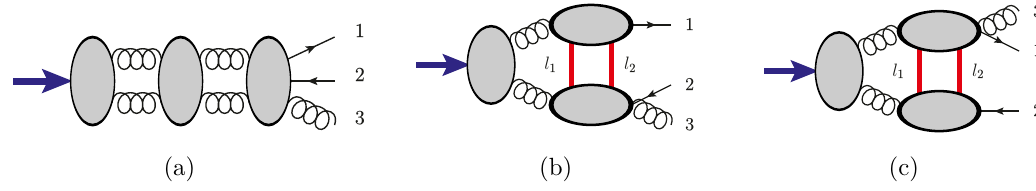
Figure 10. Unitarity cuts for the two-loop form factor